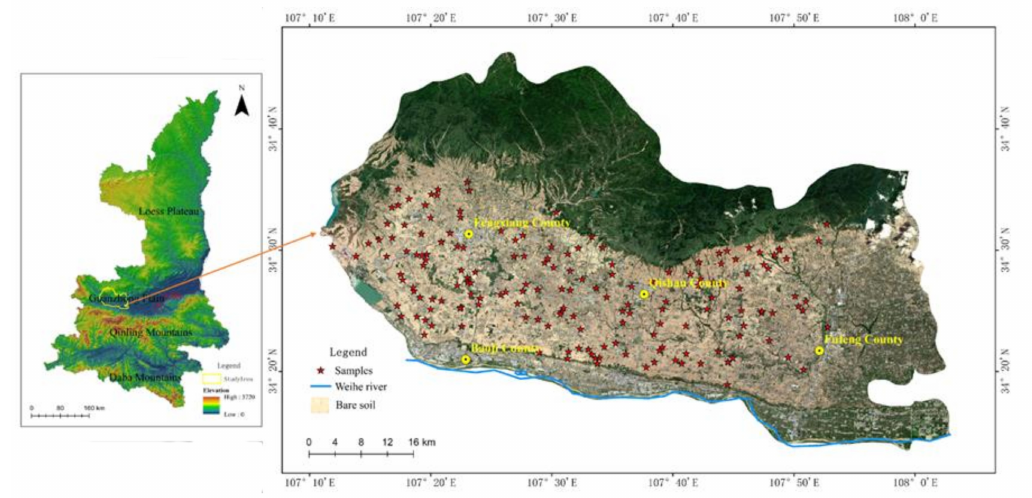
Figure 1. Location of autumnal bare farmland sample sites in the western Guanzhong Plain, China (the images containing bare farmland were obtained from Landsat 8 OLI on 12 August and 15,